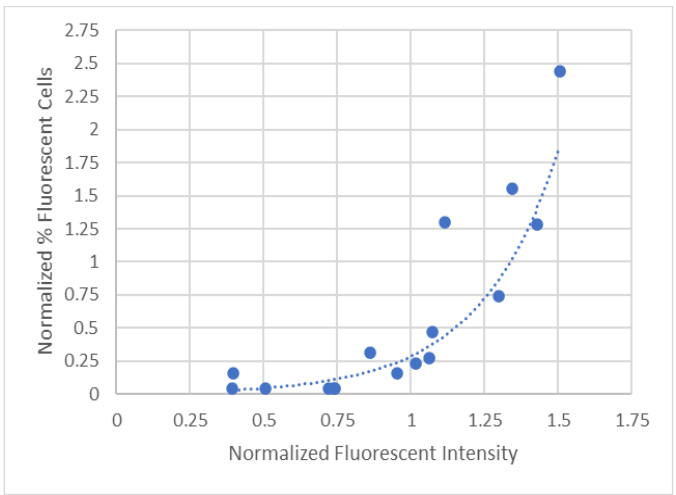
Figure 3. ( A ) Cell counts of cells incubated with NO probe (DAF-FM) at 3 different time points of ES and different neurotransmitters (Figure 1) Values are mean ± SD for n = 3 images per condition. ( B ) Fluorescence spectroscopy measurements of individual solubilized well solutions (from cells counted in Figure 1) incubated with NO probe (DAF-FM) and with or without ES and neurotrans- mitters (Figure 1) Values are mean ± SD for 60 measurements of a single well. Control Average is mean ± SD of 240 measurements from 4 replicate wells. Green bars indicate cells stimulated before or after additions, blue bars indicate cells with additions but no ES, and black bar indicates PBS control cells with no ES.